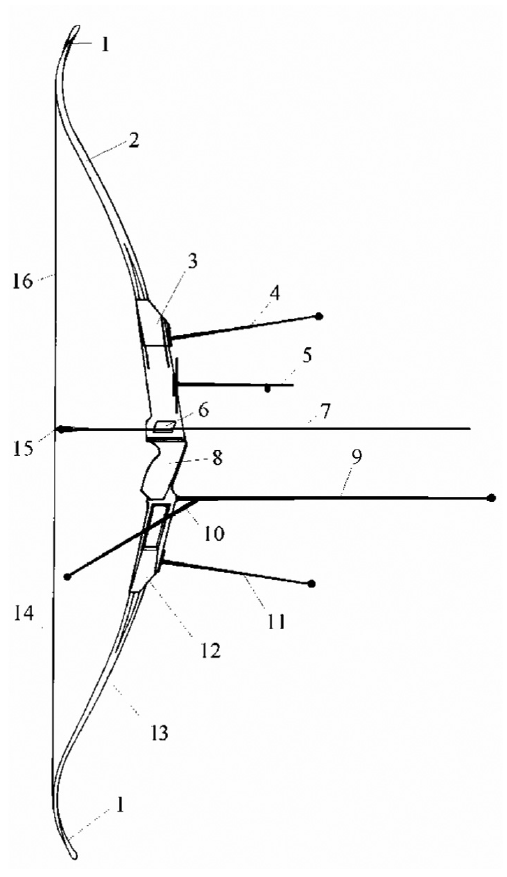
Fig. 1. A modern sport bow in its main plane [6]: 1 – tips; 2, 13 – limbs; 3, 12 – limb-angle setup mechanisms; 4 – upper stabilizer, 5 – sign; 6 – arrow rest; 7 – arrow; 8 – handle; 9 – central stabilizer; 10 – side stabilizers; 11 – lower stabilizer; 14, 16 – string branches; 15 – nock